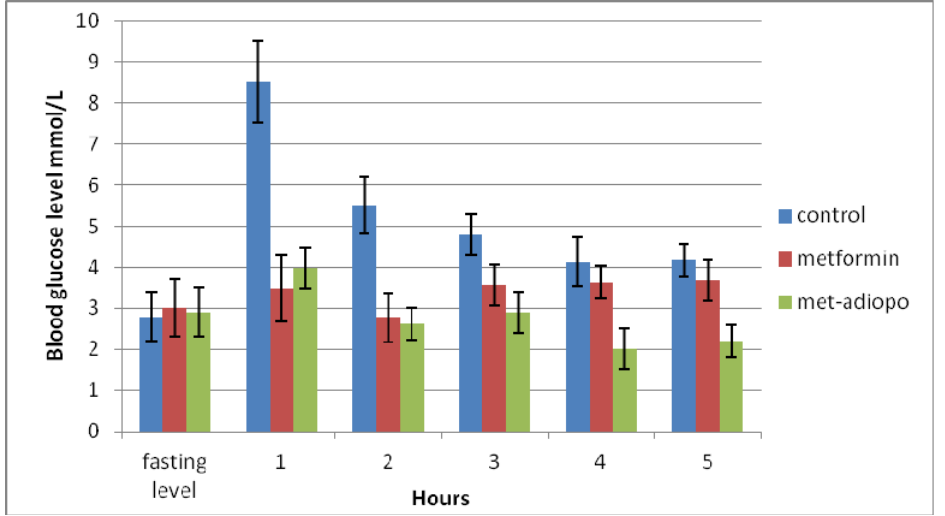
Figure 2. The blood glucose was just under 3 mmol/L at fasting level as calculated by glucometer before feeding the experimental mice. The graph shows a significant reduction of blood glucose level in the animals treated with metformin alone or in combination with adiponectin group at the 1st, 2nd, 3rd, 4th and 5th hours compared with control